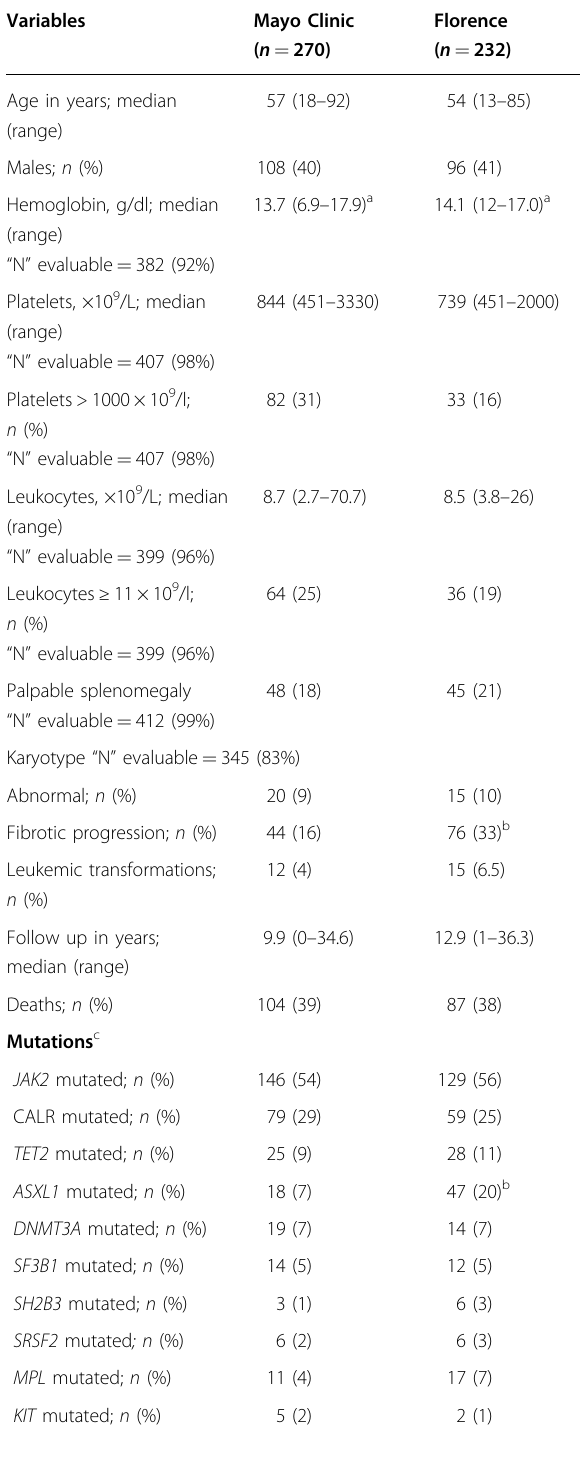
Table 1 Clinical and laboratory characteristics of 270 Mayo Clinic patients and 232 University of Florence patients with essential thrombocythemia (ET) (total n =